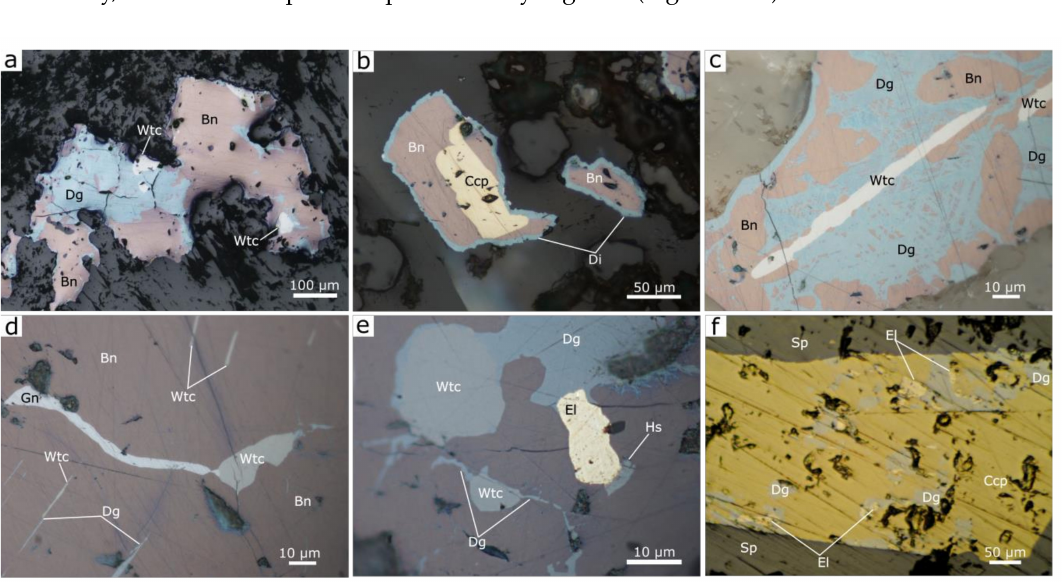
Figure 3. Photomicrographs in the plane-polarized reflected light of Cu-Au-Bi ore from the Antoniu and Antoniu North orebodies; ( a ) bornite, digenite, and subordinate wittichenite filling spaces among skarn minerals; ( b ) chalcopyrite grains partly replaced by bornite with digenite rims; ( c ) wittichenite hosted by bornite displaying network-like replacement by digenite; ( d ) galena, wittichenite and digenite hosted by bornite; ( e ) electrum associated with hessite, digenite, and wittichenite hosted by bornite; ( f ) electrum grains associated with digenite hosted by chalcopyrite. Abbreviations: Bn: bornite, Ccp: chalcopyrite, Dg: digenite, El: electrum, Gn: galena, Hs: hessite, Sp: sphalerite, Wtc: